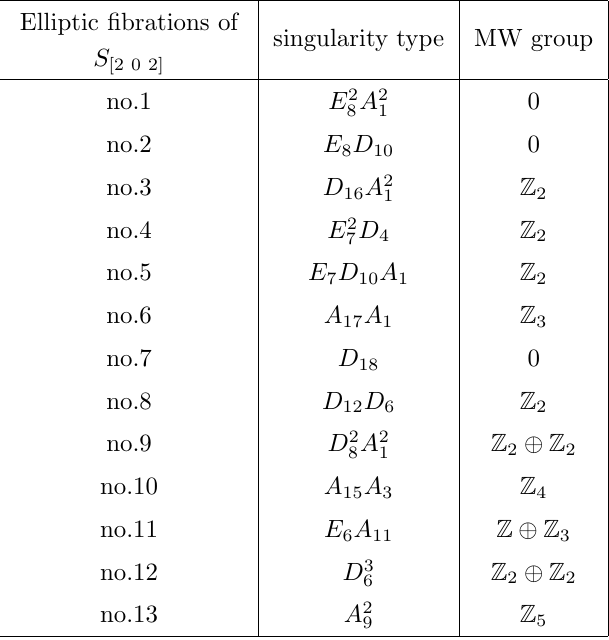
, singularity types of the (cid:12)brations, [2 0 2]